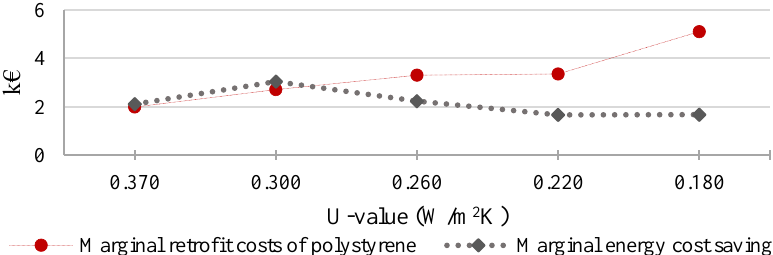
Figure 5. Marginal energy cost savings and marginal retrofit costs of extra insulation on basement walls using polystyrene